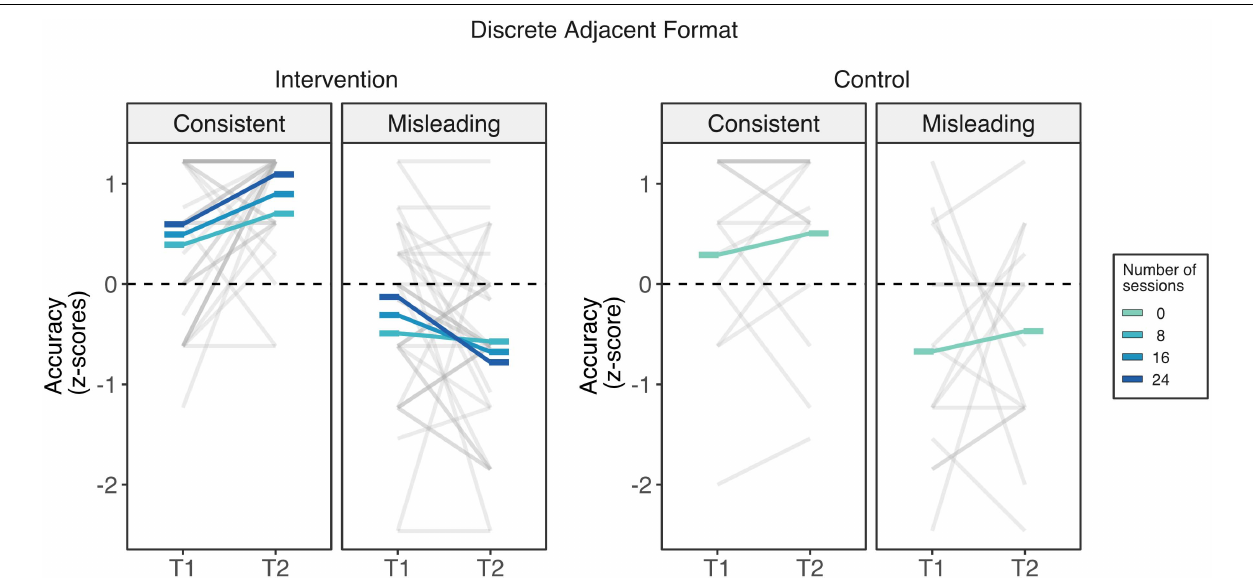
FIGURE 4 | Intervention outcomes in the non-symbolic discrete adjacent format of the Spinners task across groups. Unexpectedly, although improvements in the ability to compare pairs of spinners whose number of segments matched the proportional information varied across did not vary by the number of completed session, children’s ability to compare spinners when the number of segments was misleading was negatively related to the number of sessions. That is, children who completed 24 session (darkest blue line) showed the largest losses. Rods represents the estimated marginal means across different number of sessions of attendance from 0 sessions (control group) to 24 sessions (darkest blue).